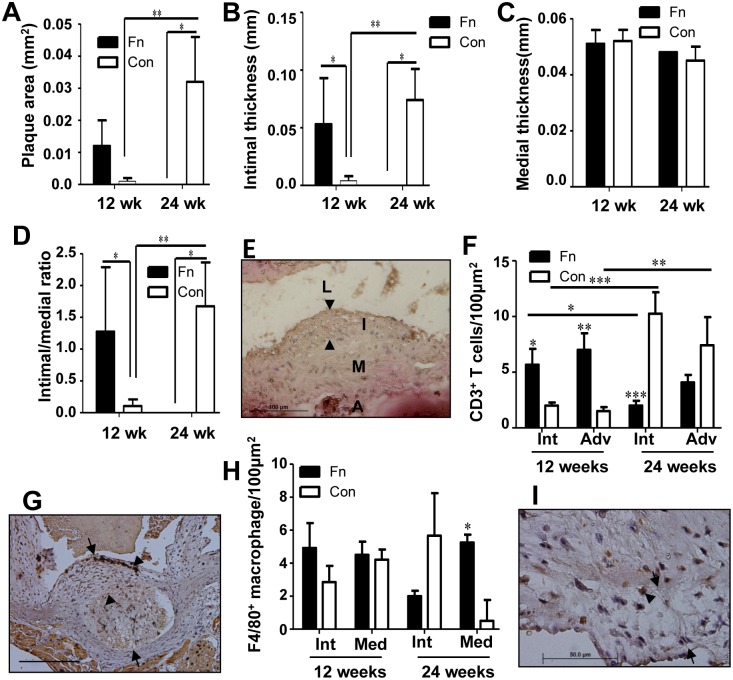
Chronic oral infection results in an unexpected reduction in plaque area at 24 weeks.(A) Infected mouse plaque area was significantly reduced when compared to sham-infected mice at 24 weeks of infection. Control mouse plaque area was significantly increased at 24 weeks relative to 12 weeks. (B) Intimal thickness at 12 and 24 weeks. (C) Medial thickness at 12 and 24 weeks. (D) Intimal/medial thickness ratios again indicate a significant reduction in plaque at 24 weeks in infected mice when compared to controls. (E) Twenty-four week-infected mouse aorta demonstrating plaque. Scale bar is 100μm. Arrowheads indicate plaque. (F) CD3+ T cell counts were significantly higher in 12 week-infected mice than controls and also higher than 24 week-infected mice. (G) Twelve-week infected mouse aorta stained for CD3+ T cells. Arrows define plaque margins, arrow heads point to CD3+ stained cells (brown staining). Scale bar is 100μm. (h) F4/80+ macrophage counts in 12 week-infected mice were unaffected. (I) Twenty-four week-infected mouse aorta stained for F4/80+ cells. Arrows define plaque margins, arrow heads point to F4/80+ stained cells. Scale bar is 50μm. Fn—F. nucleatum, Con—control, L—lumen, I, Int—intimal layer, M—medial layer, A, Adv—adventitial layer. * P<0.05, ** P<0.01, *** P<0.001.